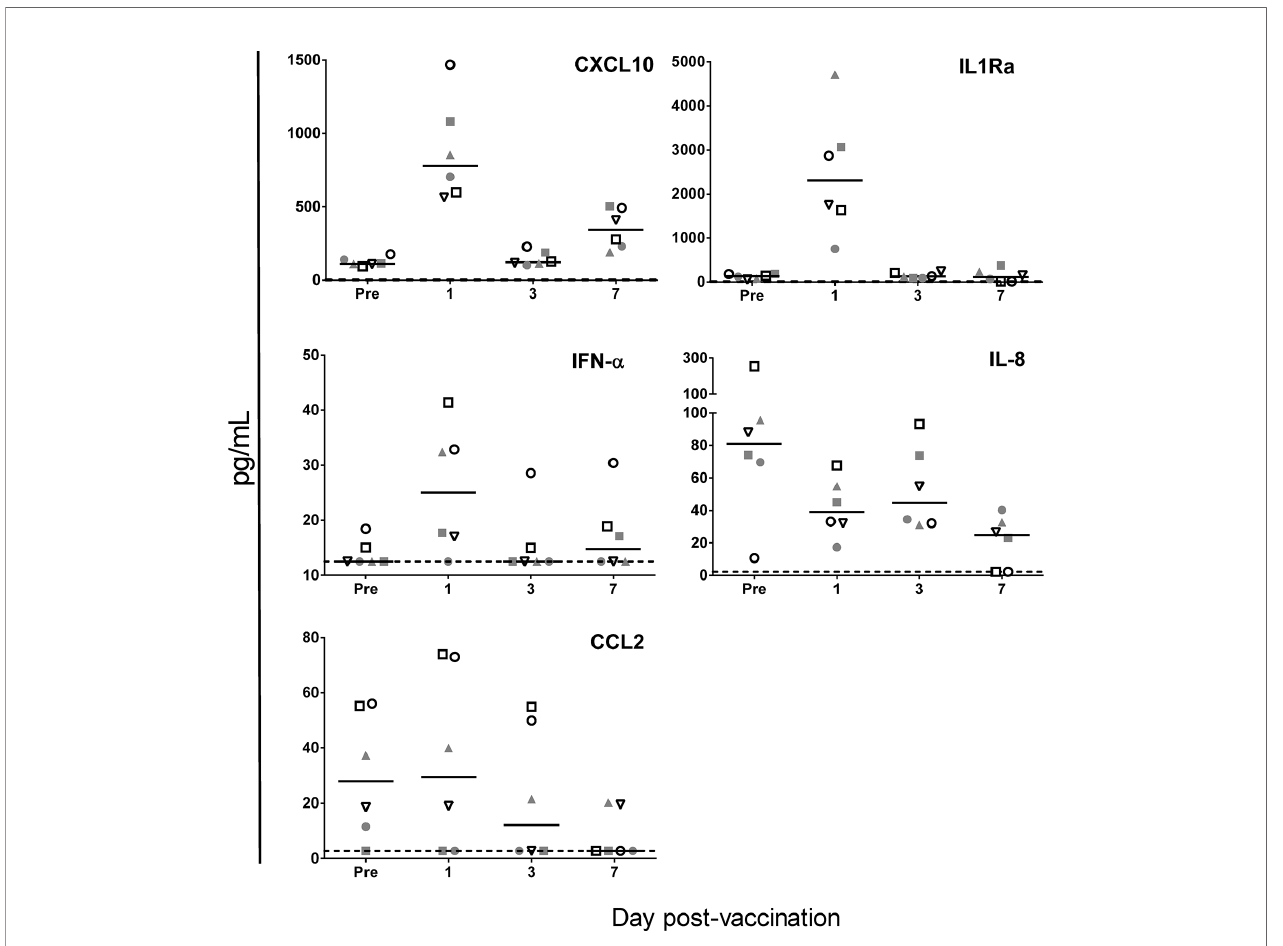
FIGURE 5 | ChAd155-vectored rabies vaccine elicits few serum cytokine responses in macaques. Cytokine levels were measured at pre-vaccination ( “ Pre ” , Day-5) and 1, 3, and 7 days post- vaccination in serum collected from six macaques injected intramuscularly with ChAd155-RG rabies vaccine (5 × 10 10 vp) at Day 0. Graphs shown [CXCL10, IFN- a (both ELISA), IL1Ra, IL-8, and CCL2 (multiplex assay)] represent the only fi ve analytes found to be modulated by vaccination, out of the panel of 30 immune-related cytokines, growth factors or activation markers tested. Each symbol represents the same animal across the graphs. Solid lines represent medians; dashed lines represent limits of detection applied for statistical calculations. An ANOVA model of the log 10 -transformed geometric mean concentrations revealed signi fi cant changes as compared to prevaccination for CXCL10 at Days 1 and 7, IL-1RA at Day 1 (all P < 0.001) and IL-8 at Day 7 ( P < 0.01), as well as a borderline signi fi cant change ( P = 0.05) for IFN- a at Day